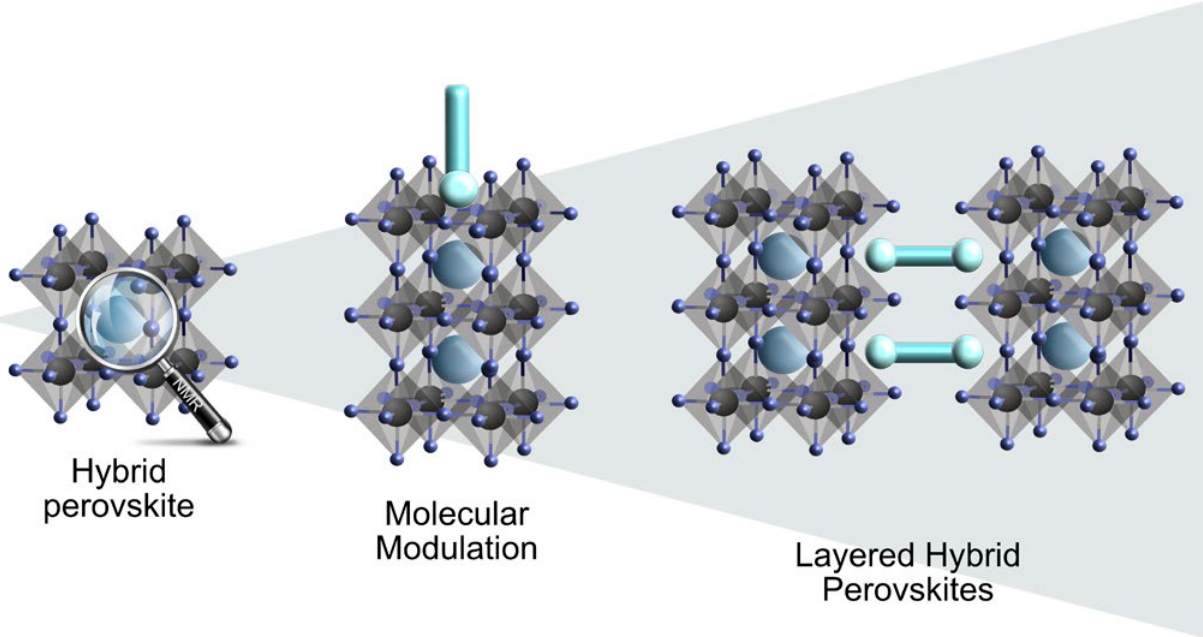
Figure 8. Gradual evolution of hybrid perovskite materials. Schematic representation of development through compositional engineering and molecular modulation to the layered hybrid perovskite